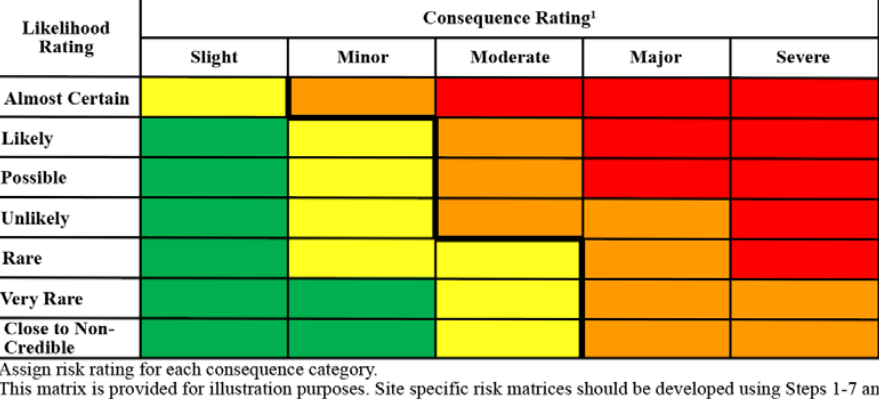
Figure 5. Example risk matrix considering major hazard aversion and threshold for quantitative